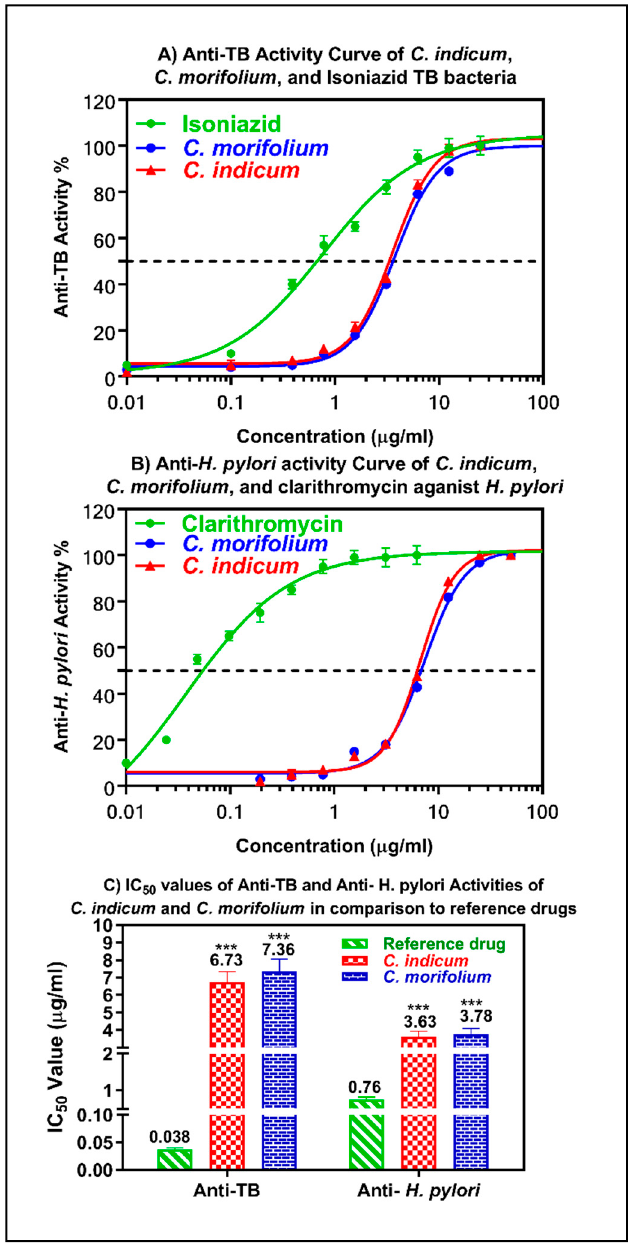
Figure 6. Anti-mycobacterial and anti- Helicobacter pylori activity of the essential oils obtained from C. indicum and C. morifolium flower heads versus reference drugs. The means with different Stars are significantly different ( p < 0.05).